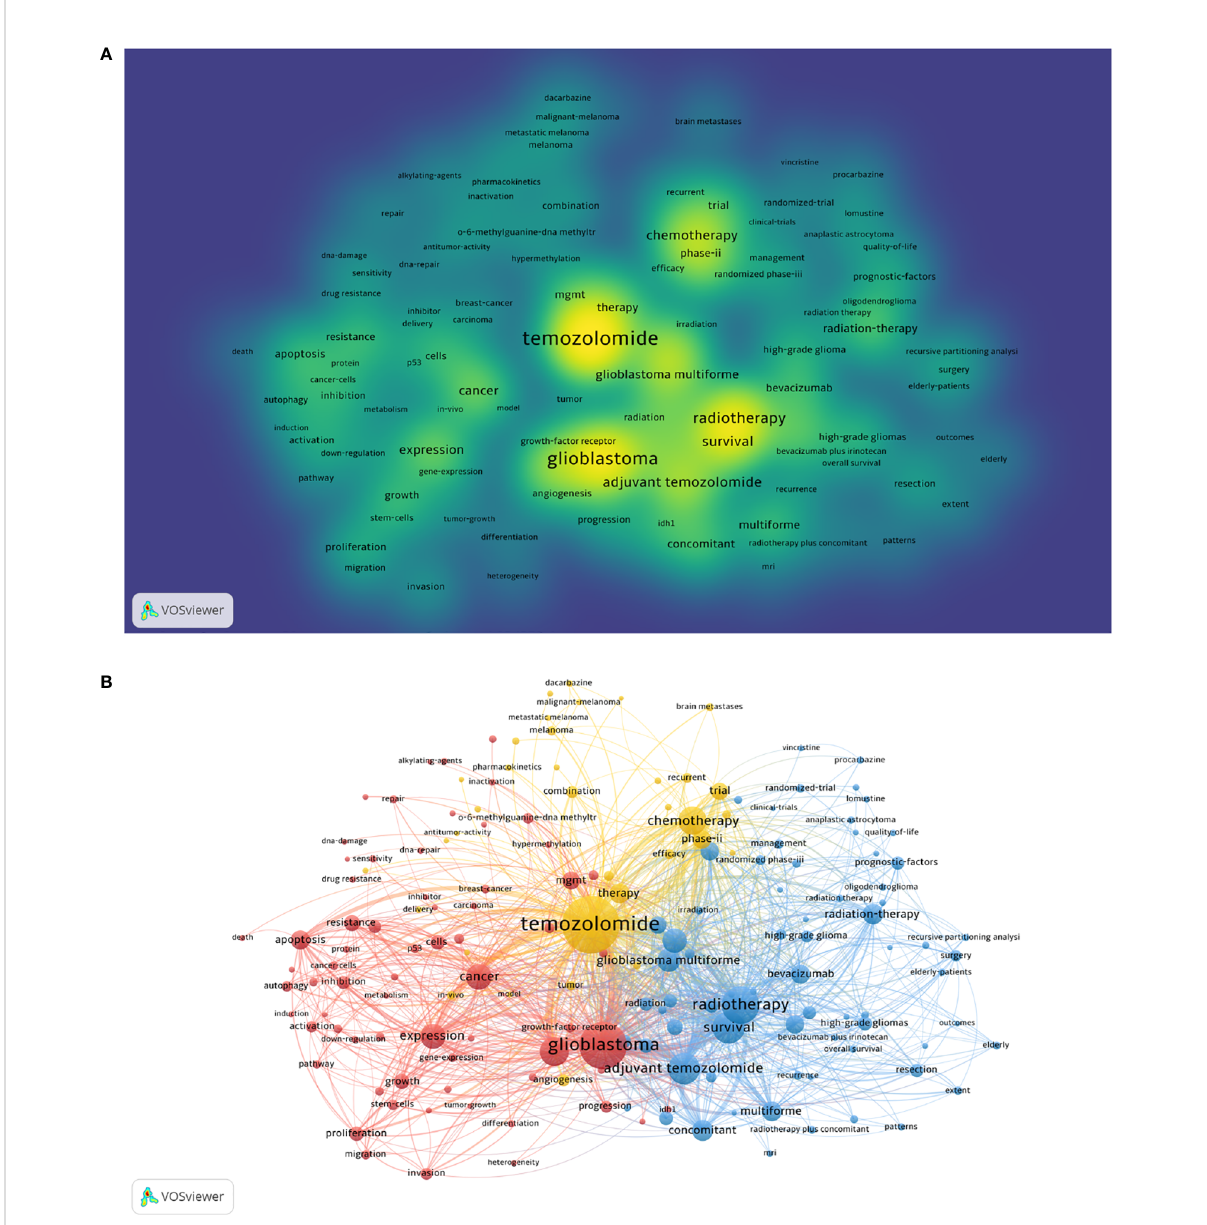
FIGURE 11 Keywords analysis. (A) Heatmap visualization analysis of keywords appearing more than 118 times in TMZ fi eld from 1994-2021. Warmer spots indicate hotter research keywords, and cooler spots show colder keywords. (B) Cluster analysis of keywords appearing more than 118 times in TMZ fi eld, 1994-2021. From: CiteSpace, VOSviewer doi: